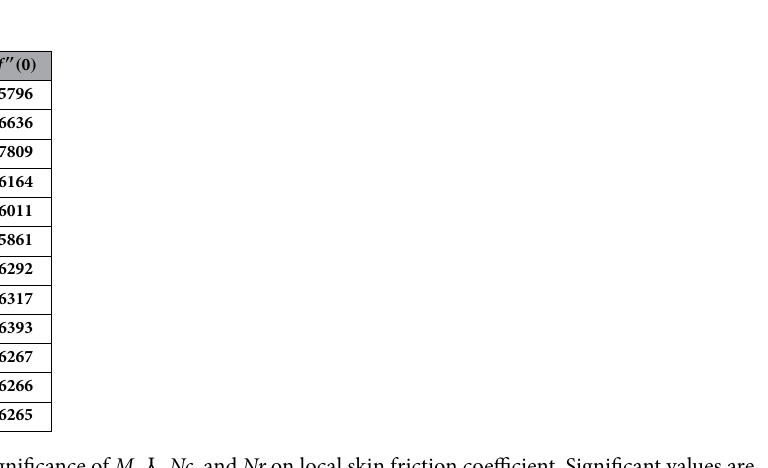
Table 1. Visualizes the significance of M, ⅄ , Nc, and Nr on local skin friction coefficient. Significant values are in